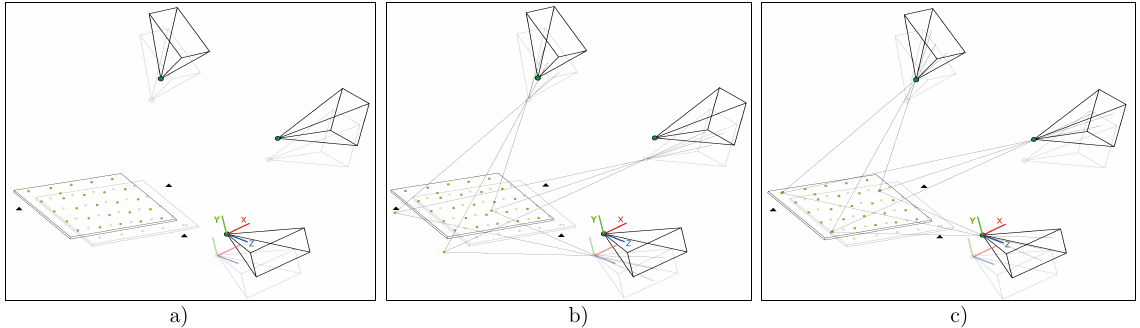
Figure 4: Dynamic referencing, a) camera motion and object motion occured, b) point reconstruction in the local camera frame, c) points after the spatial similarity camera motion